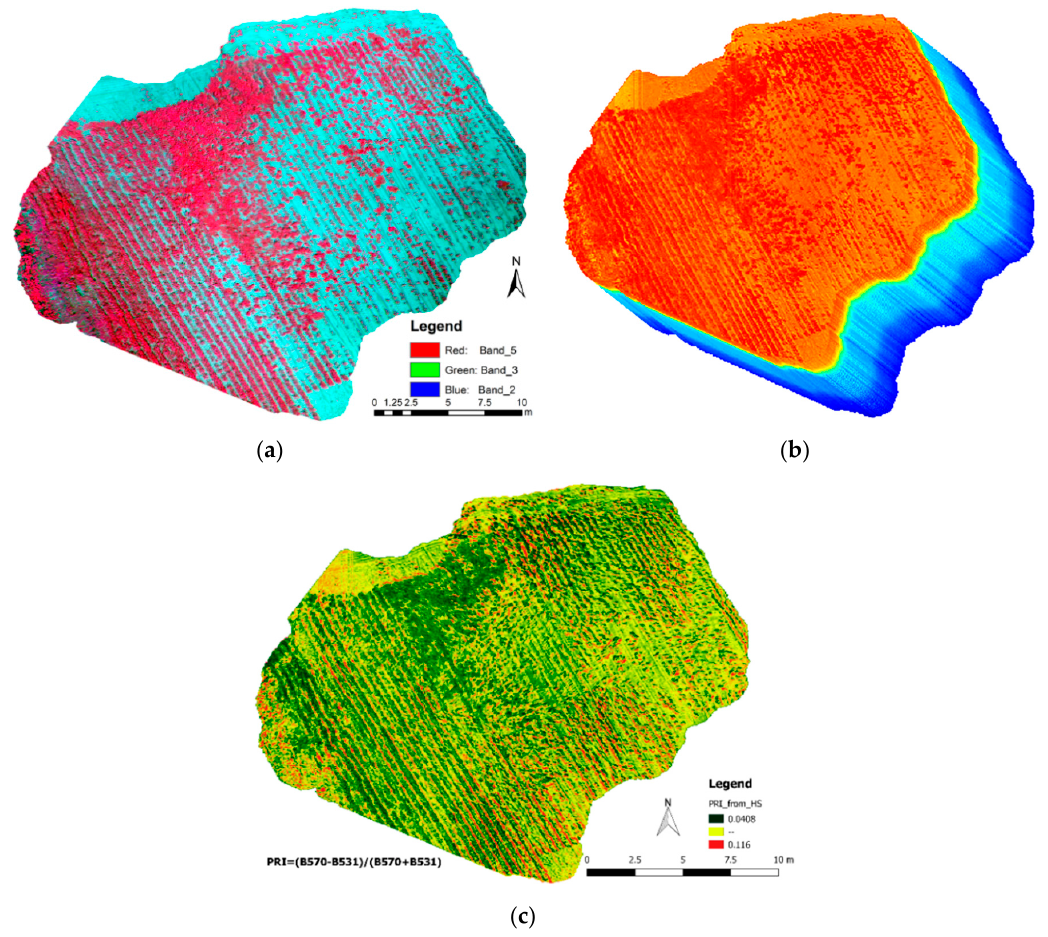
Figure 10. Data fusion and hyperspectral imagery generation. ( a ) A preview of the multispectral subarea mosaic in false color (RGB: 800 nm, 680 nm, 550 nm). ( b ) The estimated hyperspectral (HS) image cube. ( c ) An example application of the estimated hyperspectral imagery: mapping a narrowband vegetation index, the Photo-chemical Reflectance Index (PRI).